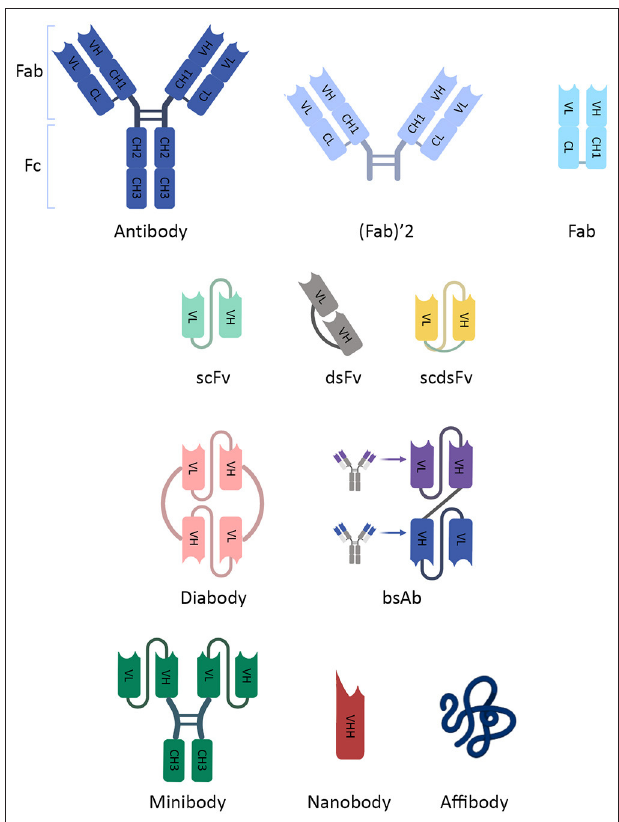
FIGURE 1 | The schematic illustration of an antibody and its fragments. The schematic illustration of an antibody and its fragments. IgG has two main parts, crystallizable Fragment (Fc) and antigen-binding Fragment (Fab). They contain fragments (constant [C] and variable [V]) which are composed of polypeptides of heavy (H) and light (L) chains. Due to inappropriate imaging characteristics, smaller fragments of Abs, which contain the variable domain for targeting, were developed. Fab and (Fab ′ )2 fragments are made by omitting the Fc region from Abs. scFv consists only of light and heavy variable chains. dsFv has a disulfide bond between chains, and scdsFv has both non-covalent and disulfide bonds to increase stability. scFv dimers (diabody) and multimers (not shown) provide more than one binding site. They can be multivalent scFvs containing different targeting fragments (bsAb). Minibody is an engineered Ab fragment, a combination of scFv with human IgG1 CH3. Nanobodies are the smallest fragment produced from natural heavy-chain-only Abs. CH, constant heavy chain; CL, constant light chain; dsFv, disulfide fragment variable; Fab, antibody fragment; Fc, crystallizable fragment;